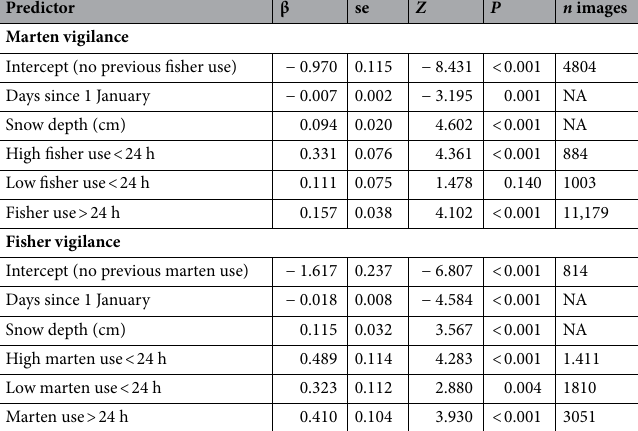
Table 1. Logistic regression fixed effect estimates with 95% for factors influencing probability of vigilance behavior for American martens and fishers, Upper Peninsula of Michigan, USA, January–March 2017–2019. For each species, occasions with no previous observations of the other species were estimated within the intercept. Both models included year of survey as a random effect.